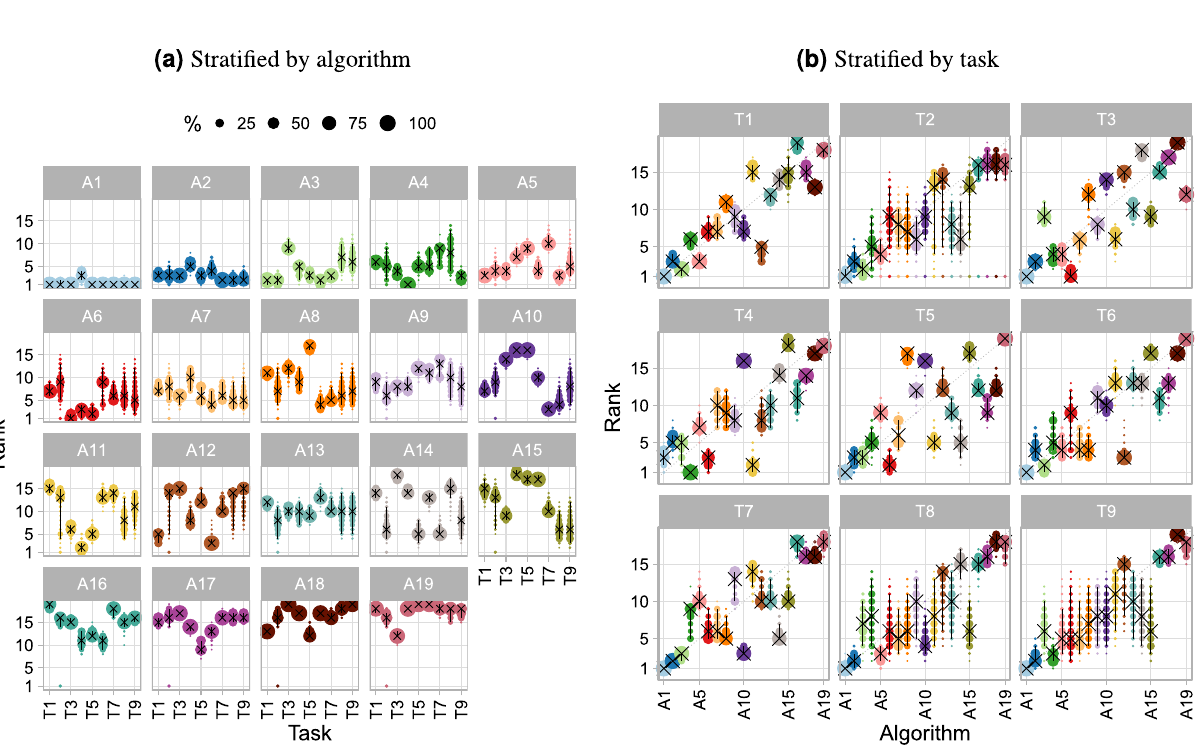
Figure 17. Rank distributions of each algorithm across bootstrap samples stratified by algorithm ( a ) and task ( b